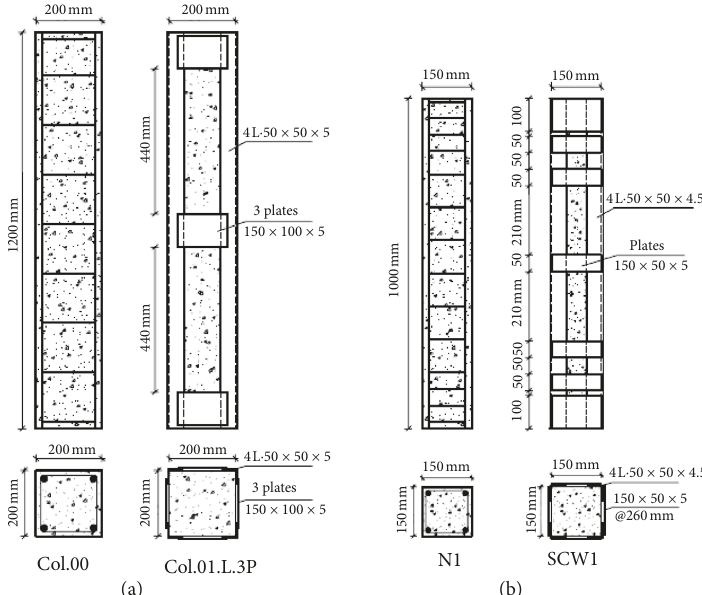
Figure 1: RC column geometrical details according to previously published work. (a) Belal et al. [3]. (b) Tarabia and Albakry